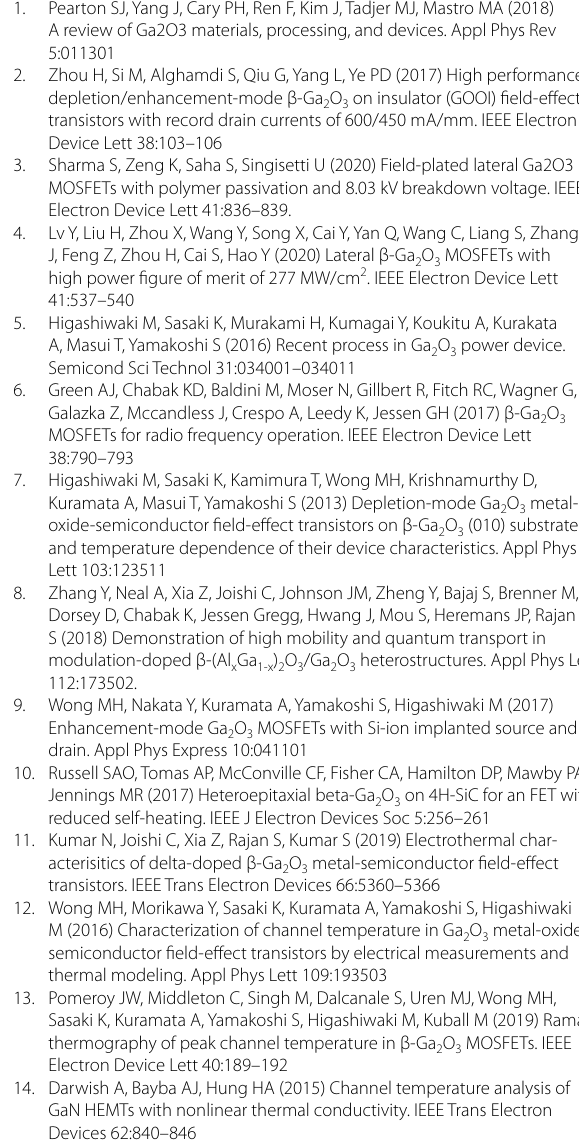
Fig. 5 Comparison of T int between simulated and calculated by Eq. (10) at different